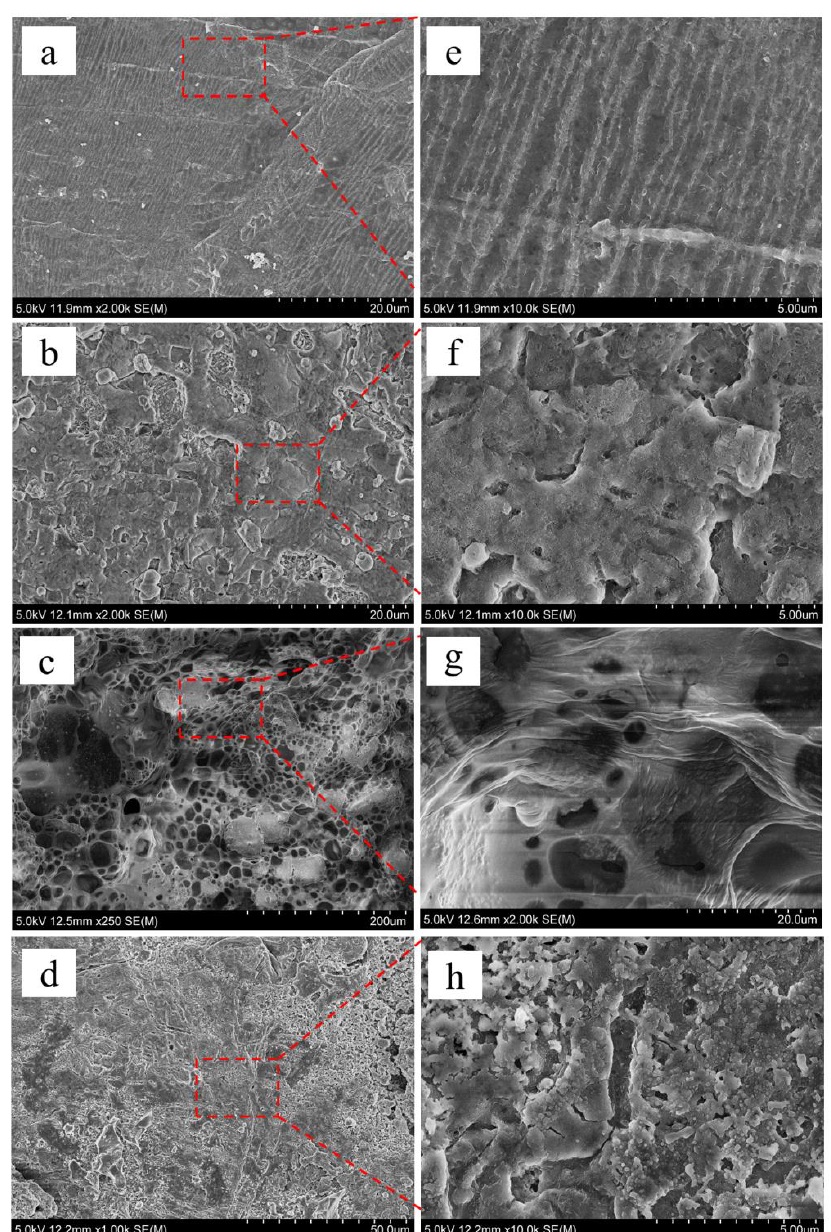
Figure 7. SEM images of lithium negative electrode: ( a ) Fresh lithium tablets, ( b ) in Li|GPE-80|Li cell after 1000 cycles, ( c ) in liquid electrolyte after 80 cycles, ( d ) and in GPE-80 full cell after 80 cycles. ( e ), ( f ), ( g ), and ( h ) are magnified images of selected areas in ( a ), ( b ), ( c ), and ( d ), respectively.